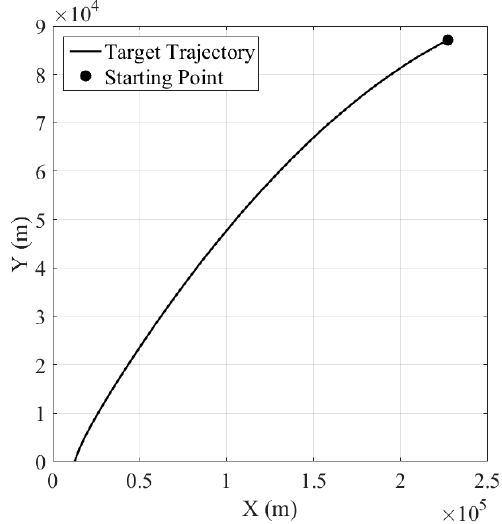
Figure 4 . Ballistic target trajectory. Figure 4. Ballistic target trajectory. Sensors 2016 , 16 , 1289